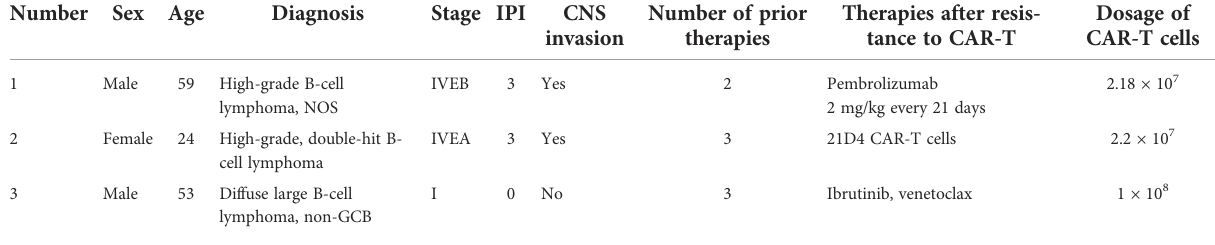
TABLE 1 Clinical information of the three patients with R/R B- cell